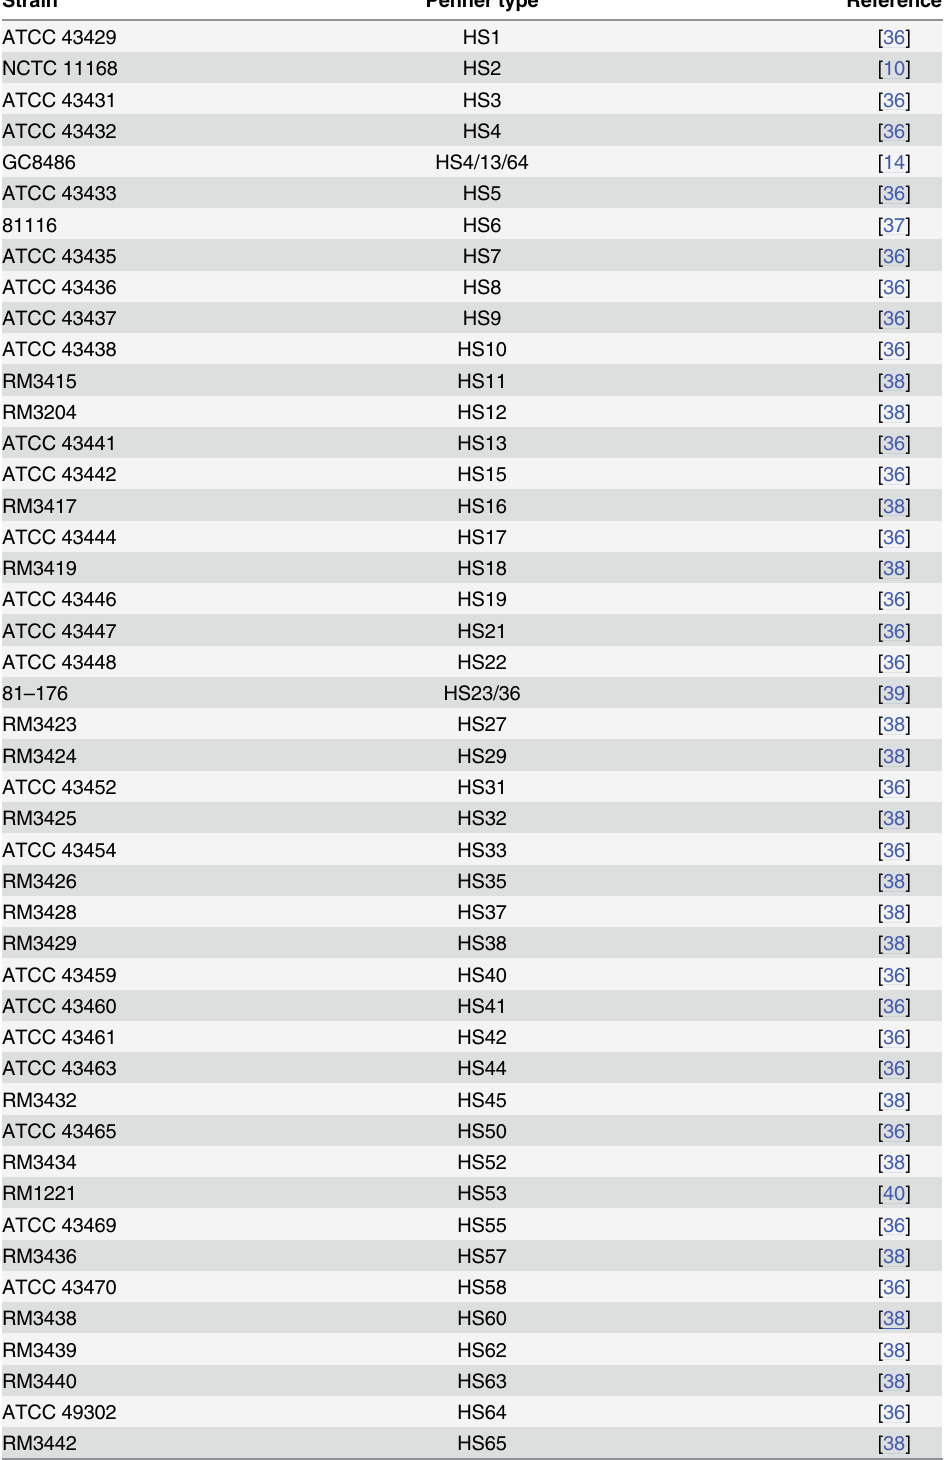
Table 1. Bacterial strains used for analysis and validation of the capsule multiplex